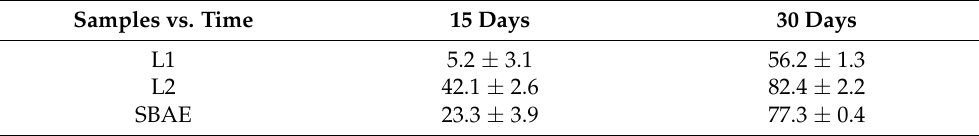
Table 2. BIC% values recorded on the L1, L2, and SBAE titanium implants after 15 and 30 days. Samples vs. Time